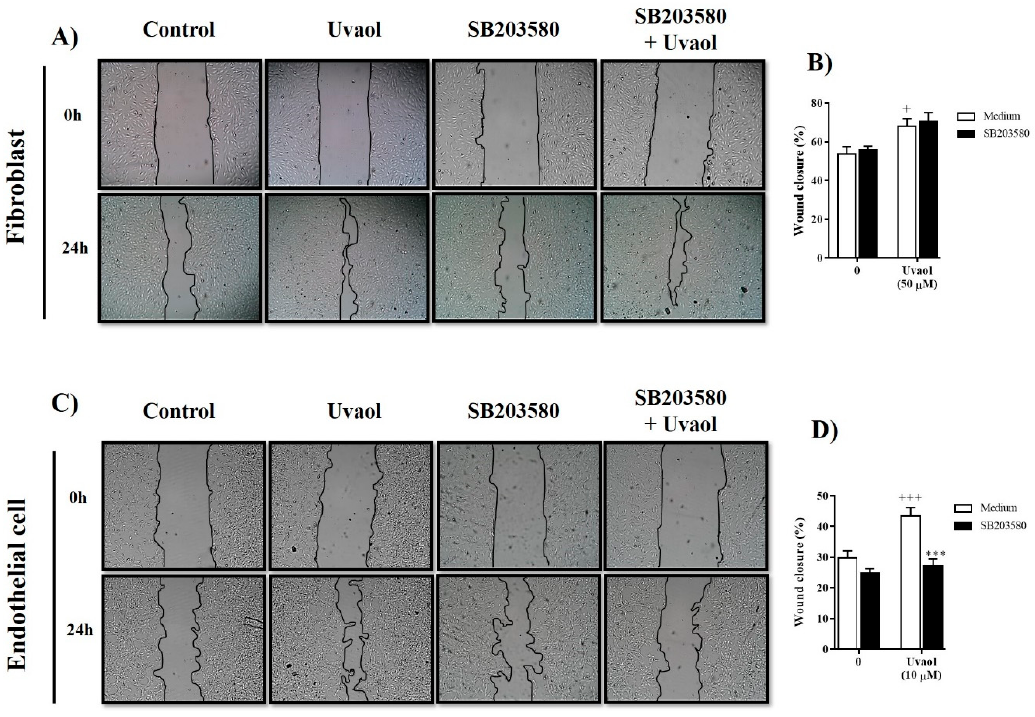
Figure 7. Inhibition of the p38-MAPK signaling pathway suppressed uvaol-improved migration in endothelial cells but not in fibroblasts. Scratch wounds were created in monolayers of cells using a sterile pipette tip. Representative photomicrography images showing the scratched area of fibroblasts ( A ) and endothelial cells ( C ) cultured with medium, uvaol or SB203580 (a p38-MAPK inhibitor, 10 µM) in the presence of uvaol for 24 h (magnification 40×). The percentage of the scratch covered was measured by quantifying the total distance that cells moved from the edge of the scratch towards the center of the scratch, using ImageJ software, followed by conversion to a percentage of the wound that was covered ( B , D ). Bars represent mean ± SD of three independent experiments. Statistical di ff erences were detected with two-way ANOVA followed by the Bonferroni test. ( + ) p < 0.01 and ( +++ ) p < 0.001 compared to medium-treated cells, (***) p < 0.001 compared to uvaol-treated